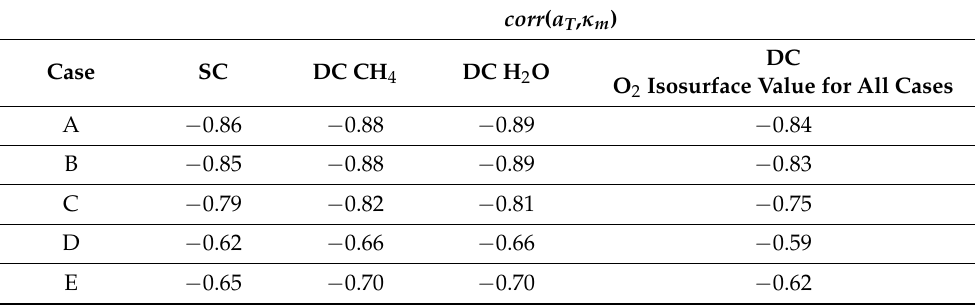
Figure 11. Joint PDF of normalised tangential strain rate a T × δ L / S L and normalised mean curvature κ m × δ L on c = 0.8 progress-variable isosurface for top to bottom cases A–E for (1st column) SC and (2nd to 4th column) DC simulations for reaction progress variable based on CH 4 , H 2 O,O 2 mass fractions. Table 9. Correlation coefficients between tangential strain rate and curvature for the c = 0.8 isosurface value for all